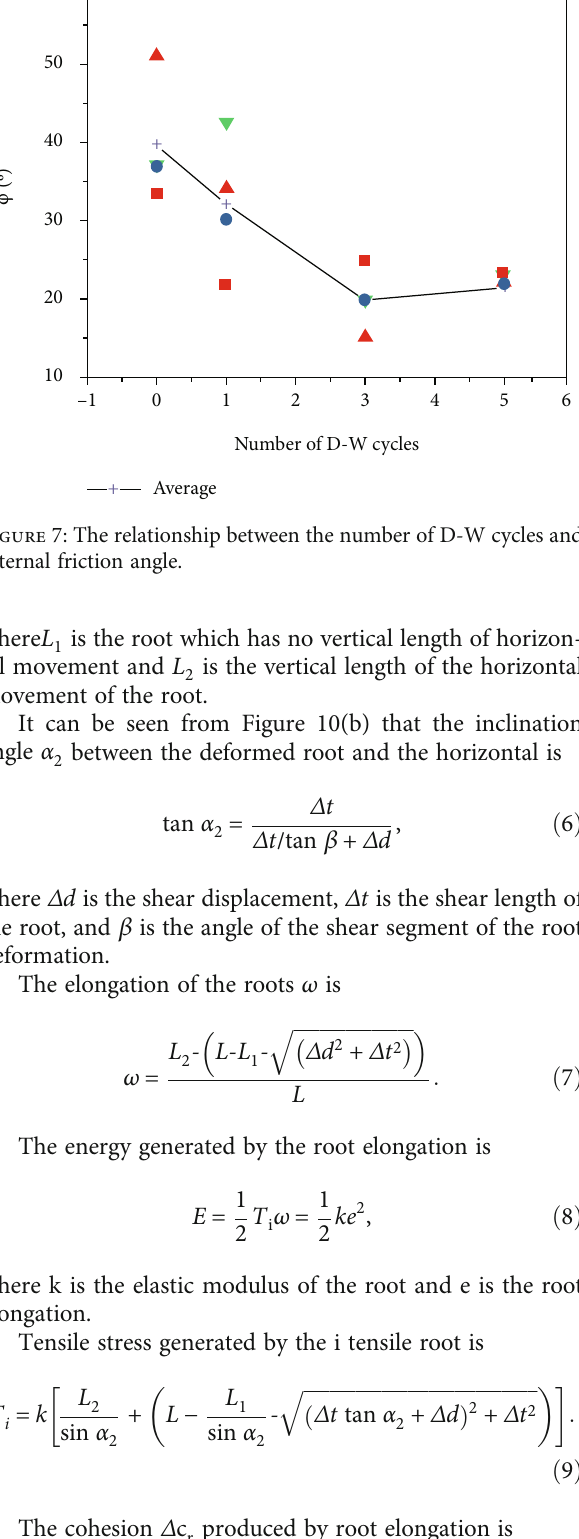
Table 5: Range analysis for cohesion.